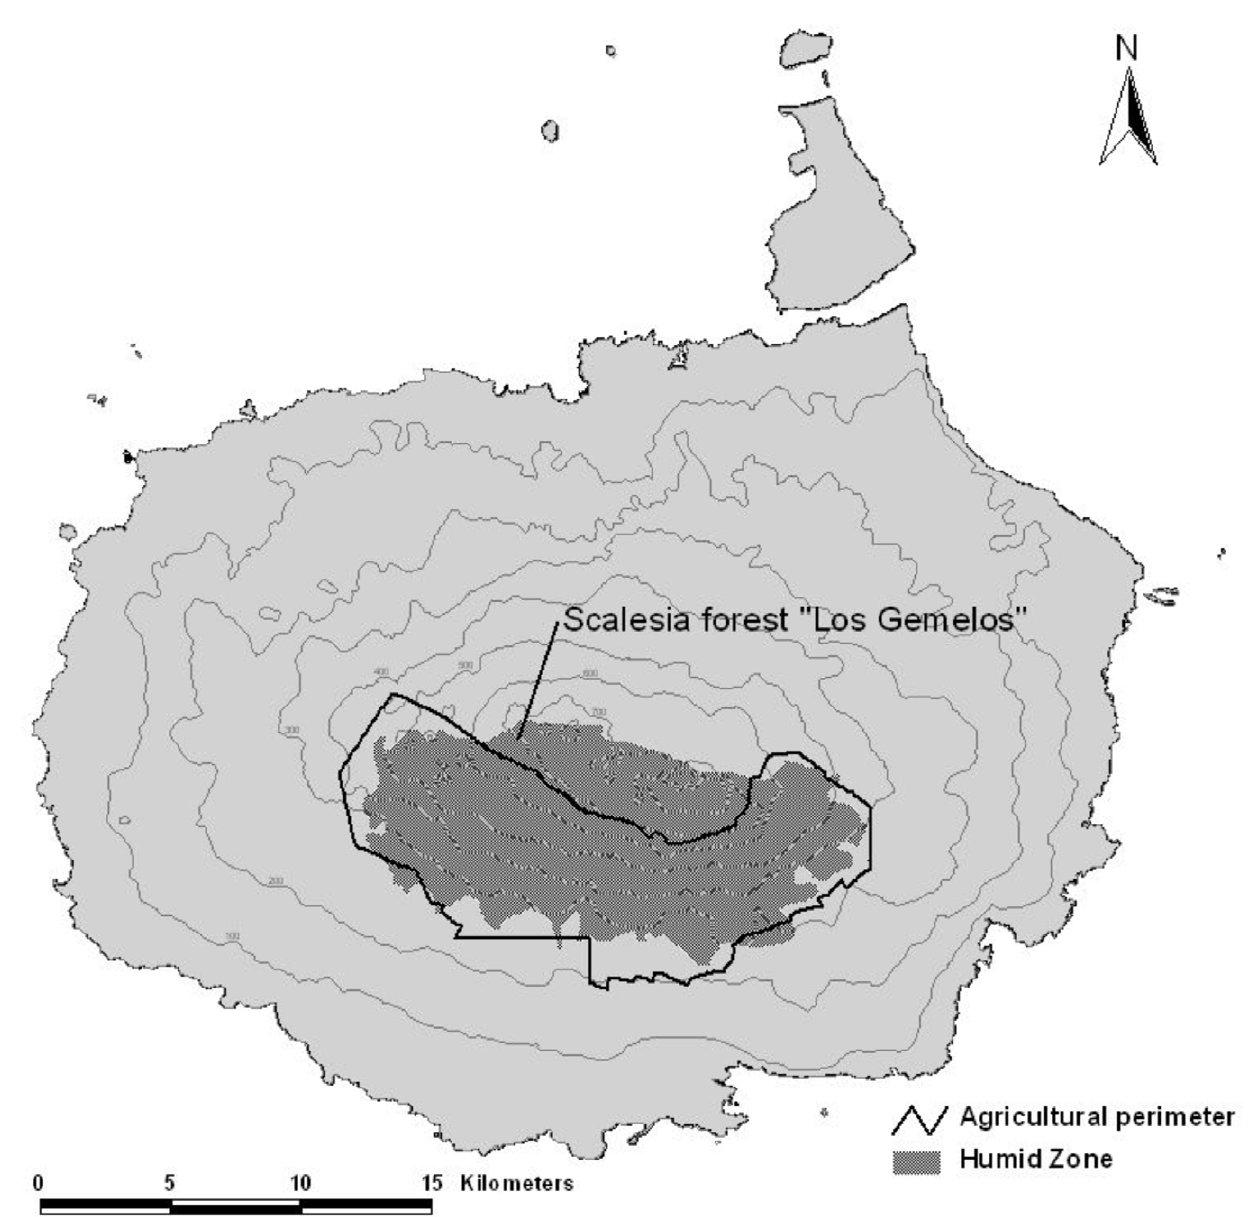
Figure 1. Map of Santa Cruz Island in Galapagos, showing the limit of the humid zone, the mostly overlapping agricultural zone and the location of the Los Gemelos study site.